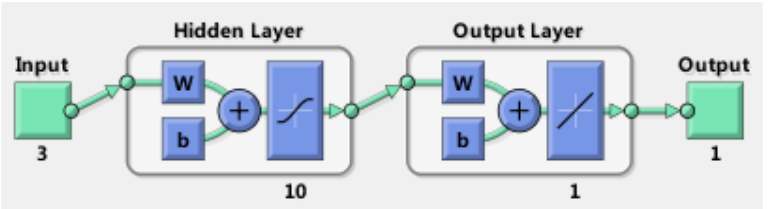
Figure 7. Schematic of the simulation platform. In Figure 7, Part 1 of the simulation platform is utilized to collect experimental data as stated in 4.3.2 (Step 1), which are used to train the four networks based on GA optimized ANN algorithm. Part 2 of the simulation platform is designed to realize the angular rate sensing of the spacecraft with the proposed method. The key parameters of the GyroWheel system are given in Table 1, and the parameters of the